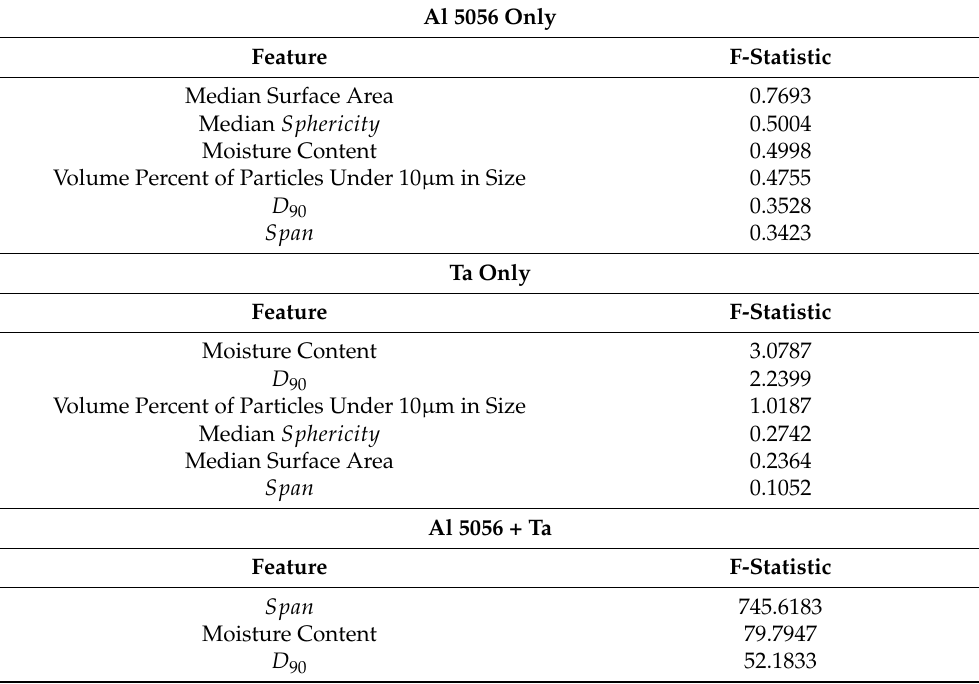
Table 5. F-statistic calculated for the features considered in the Al 5056 Only, Ta Only, and Al 5056 + Ta datasets after VIF